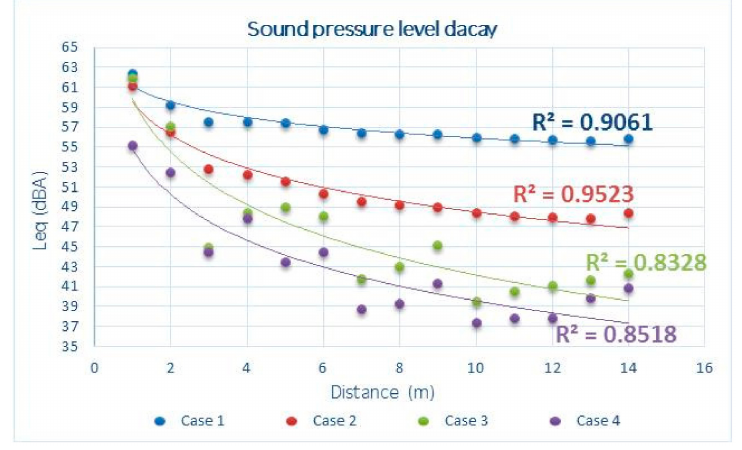
Figure 8. Sound pressure level vs. distance from the source and R 2 values of logarithmic trend lines for office A.